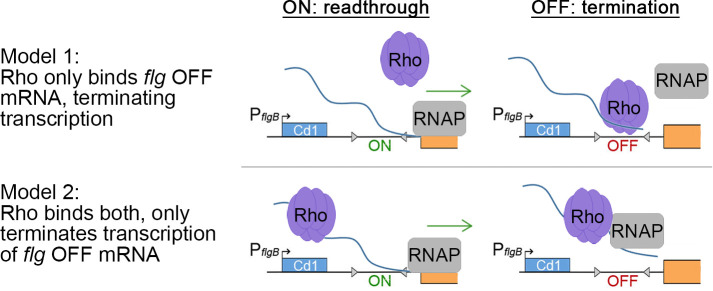
Proposed models of direct Rho binding and inhibition of transcription readthrough of flg OFF mRNA.Model 1: Rho distinguishes between flg ON and OFF mRNA by preferentially binding to flg OFF mRNA. This may be due to the presence of rut sequences that are absent in the flg ON. Model 2: Rho binds flg ON and OFF mRNAs equally, 5’ of the flagellar switch. Transcription termination may then be differentially influenced by the presence of an additional sequence required for termination (e.g. a RNA polymerase pause site) only in flg OFF mRNA.